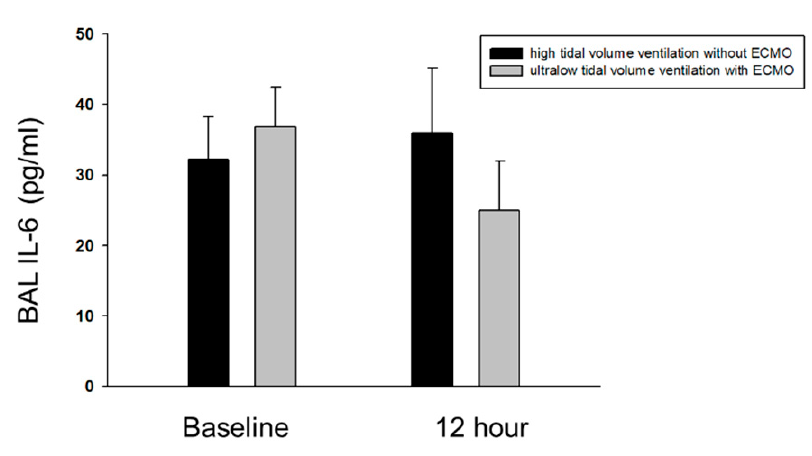
Figure 3. Comparison of IL-6 cytokine in bronchoalveolar lavage fluid; BAL: Bronchoalveolar lavage fluid, ECMO: Extracorporeal membrane oxygenation.